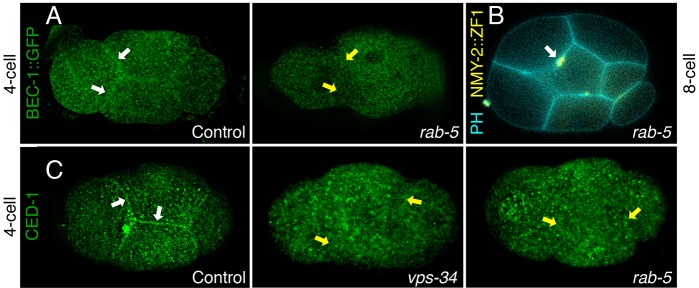
RAB-5 and PI3K regulate trafficking of the phagocytic receptor CED-1 to the plasma membrane. (A) BEC-1::GFP (green) localizes to the plasma membrane before midbody internalization (white arrows) in controls (left, n=22/25 embryos). Mild treatment with rab-5 RNAi (right) prevents BEC-1::GFP localization to the plasma membrane (yellow arrows, n=14/15) and (B) prevents midbody internalization (n=15). NMY-2::GFP::ZF1 labels midbodies (yellow) and mCh::PHPLCδ1 labels cell membranes (PH, cyan). (C) CED-1 (green) localizes to the plasma membrane (white arrows) in control embryos (left, n=48/51), but fails to localize to the membrane (yellow arrows) in vps-34 mutants (middle, n=10/14) or embryos treated with rab-5 RNAi (right, n=63/68) and is only observed in cytoplasmic puncta. Antibody stainings were performed in triplicate.